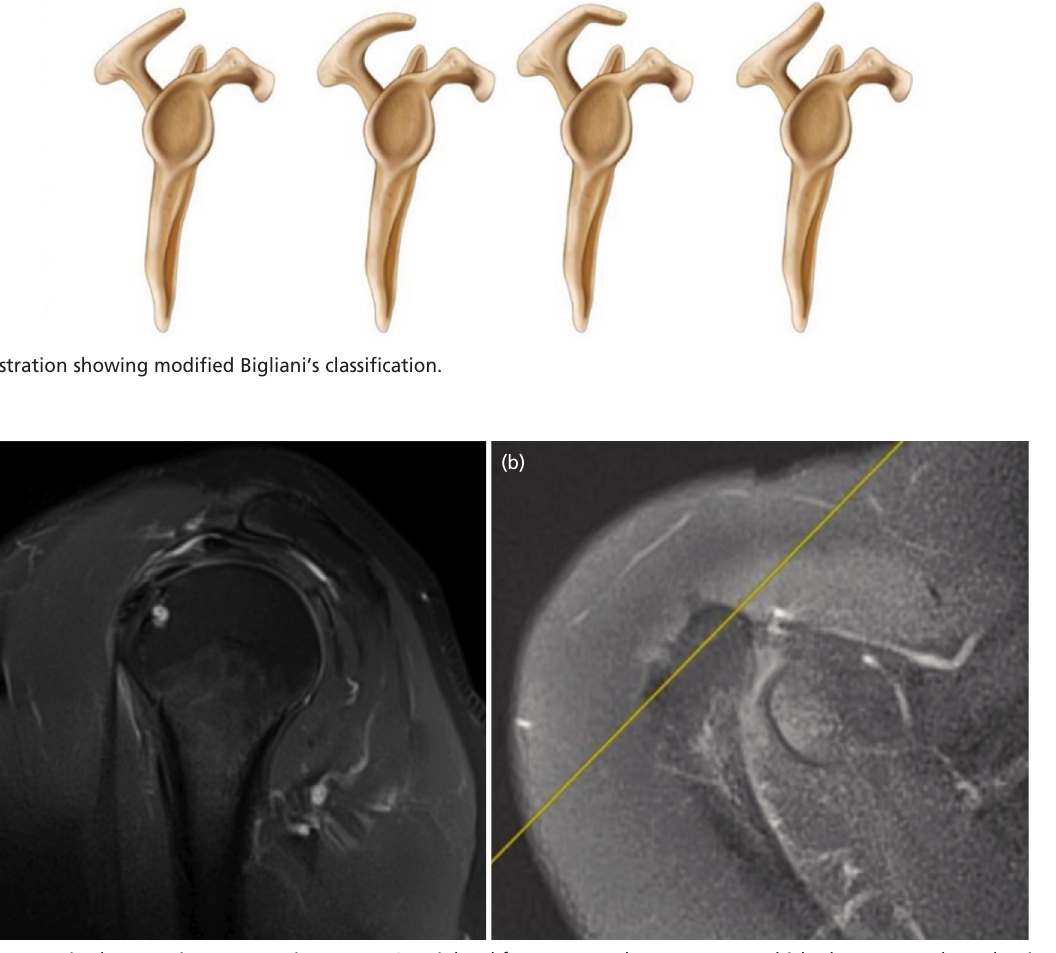
Fig. 2: (a) Parasagittal magnetic resonance image on T2-weighted fat-suppressed sequences on which observers made evaluations. (b) Selection of adequate slice position on an axial